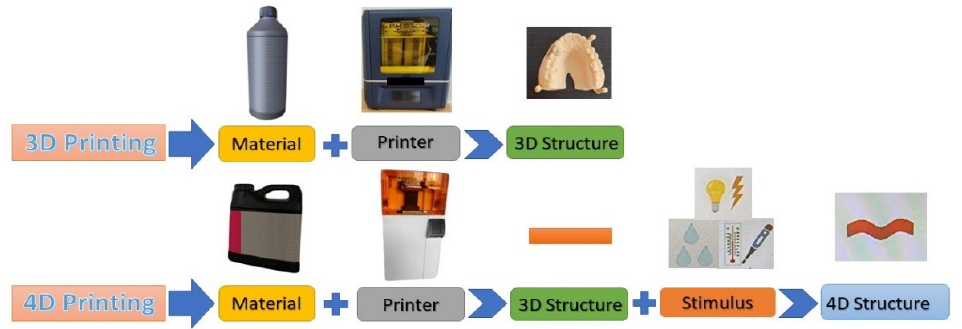
Figure 15. Comparative schematics of 3D- and 4D-printing technologies.